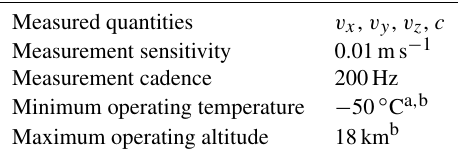
Table 1. Specifications of TILDAE system as